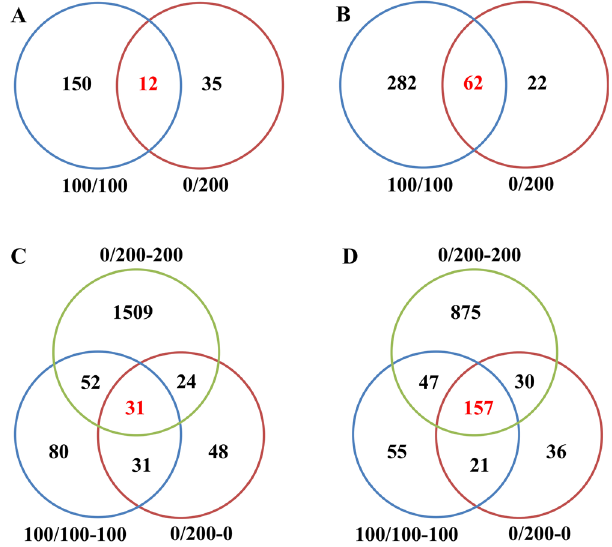
Figure 1. Venn diagram of genes identified as up- ( A ) and down- ( B ) regulated in leaves and up- ( C ) and down- ( D ) regulated in roots under uniform and non-uniform salinity